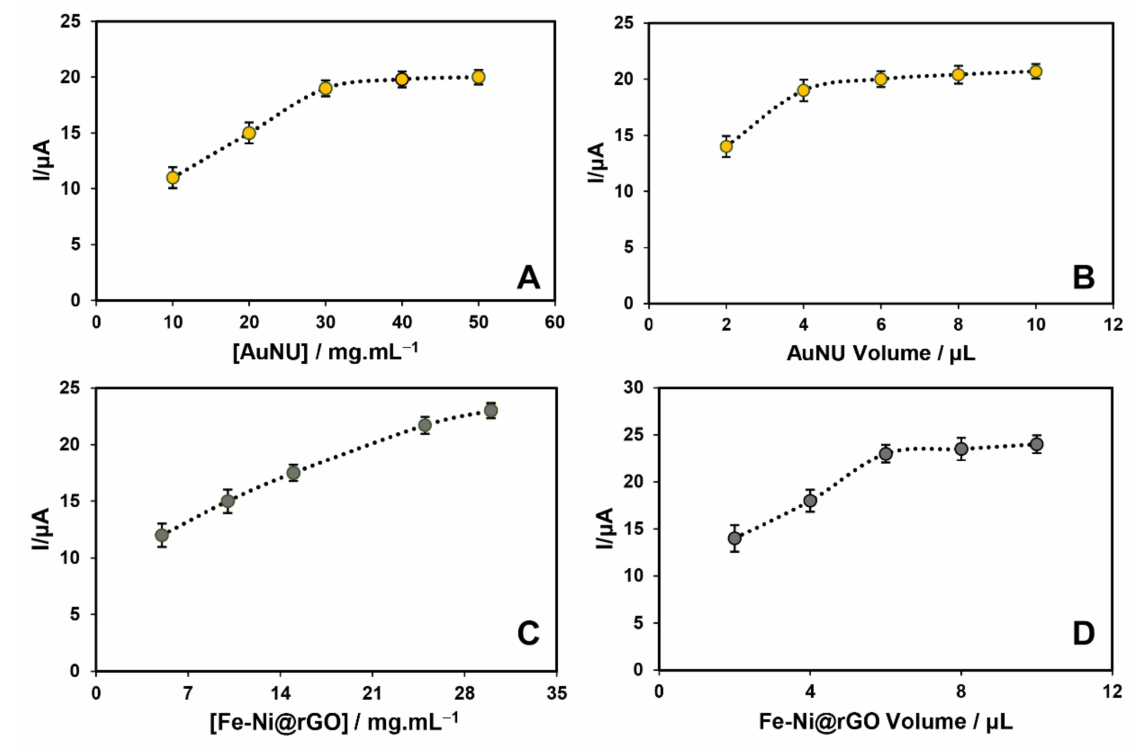
Figure 2. Optimization of concentration ( A ) and volume ( B ) of deposited suspension of AuNUs as well as concentration ( C ) and volume ( D ) of Fe-Ni@rGO. (n =